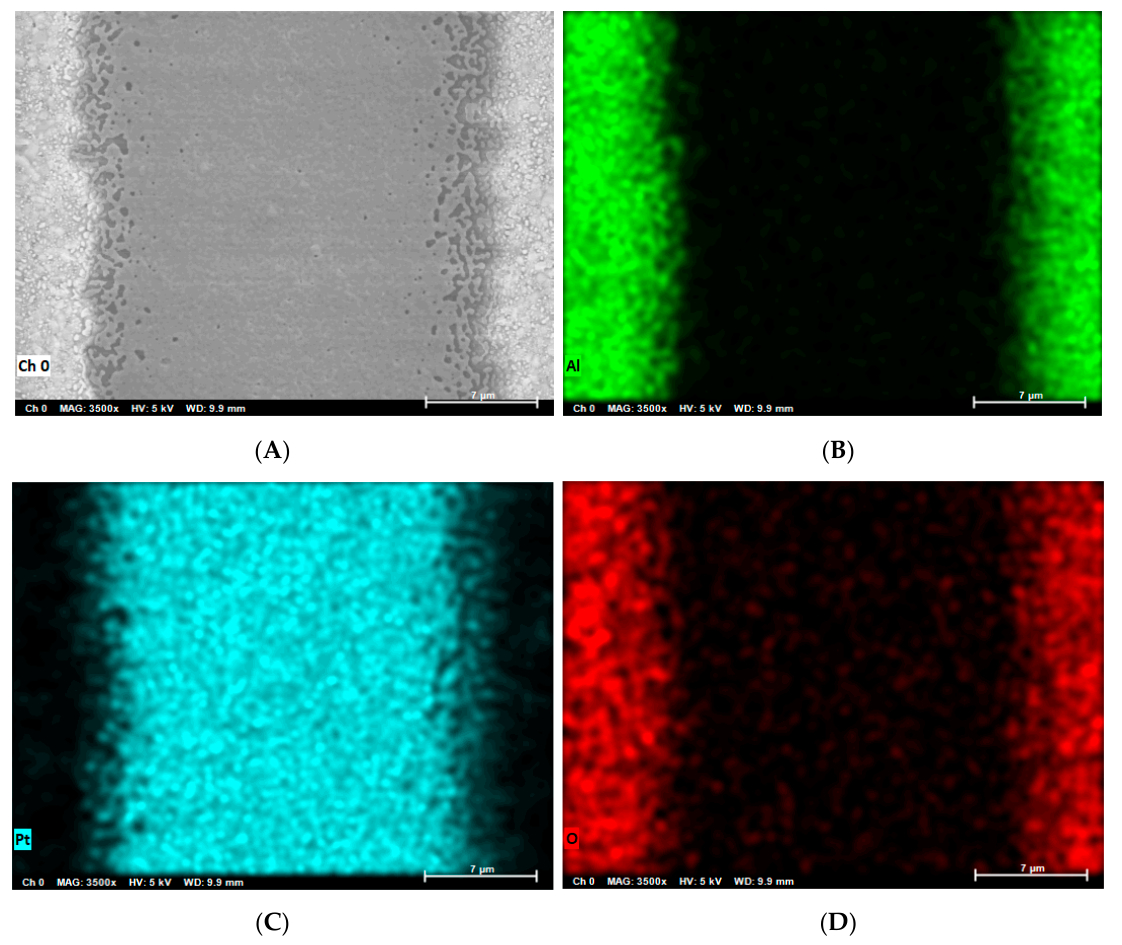
Figure 6. Scanning electron microscopy (SEM) image of the sintered line (dark grey central area) printed on alumina substrate (light grey lateral areas) ( A ) and the elemental mappings derived from the following EDX spectra: aluminum ( B ), platinum ( C ) and oxygen ( D ).